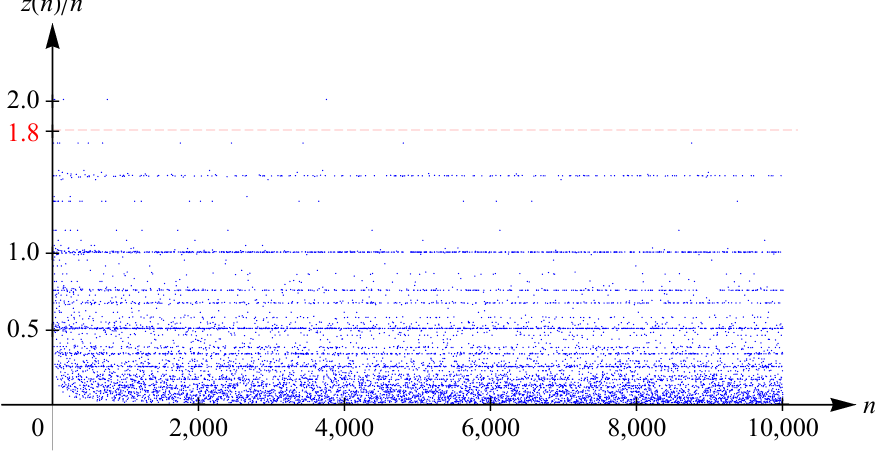
Figure 1. The scatterplot of the function z ( n ) / n for values of n from 1 to